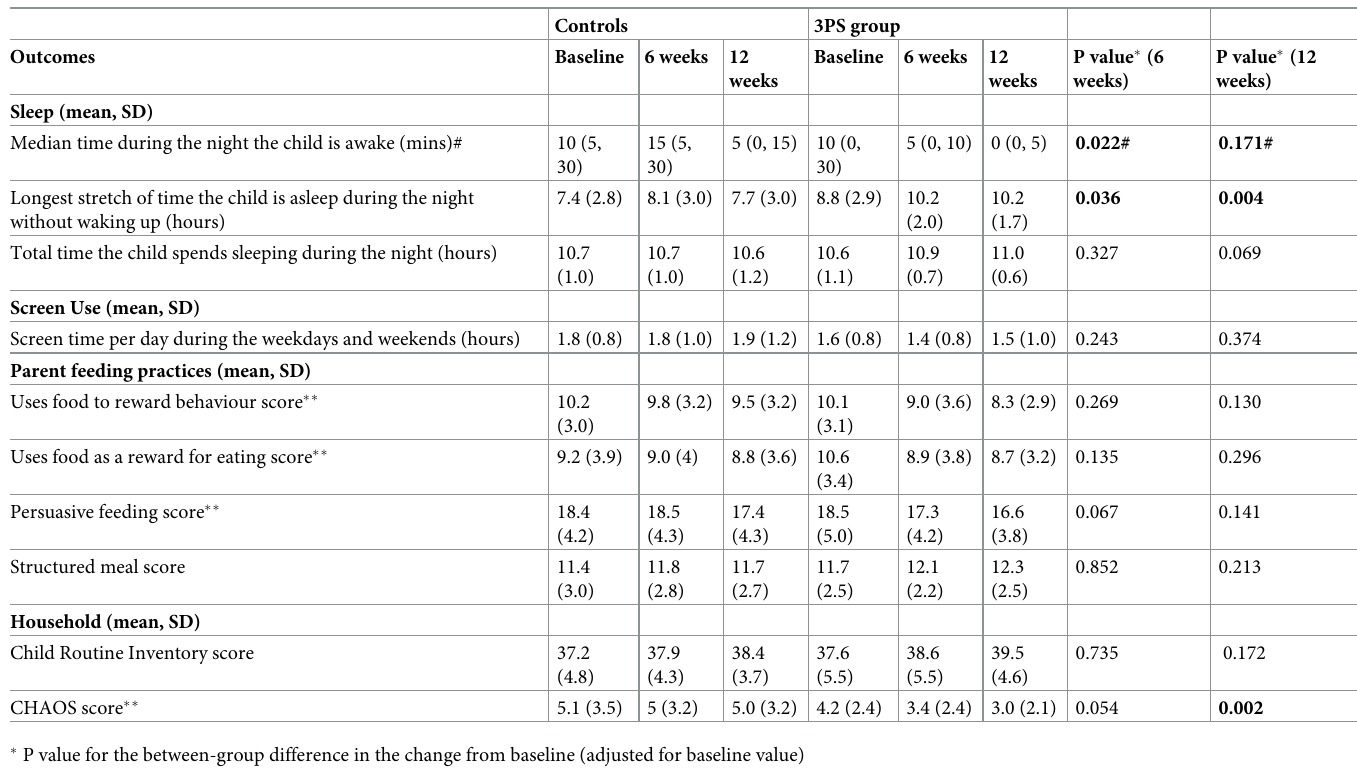
Table 2. Summary of continuous outcomes and P value for change from baseline between